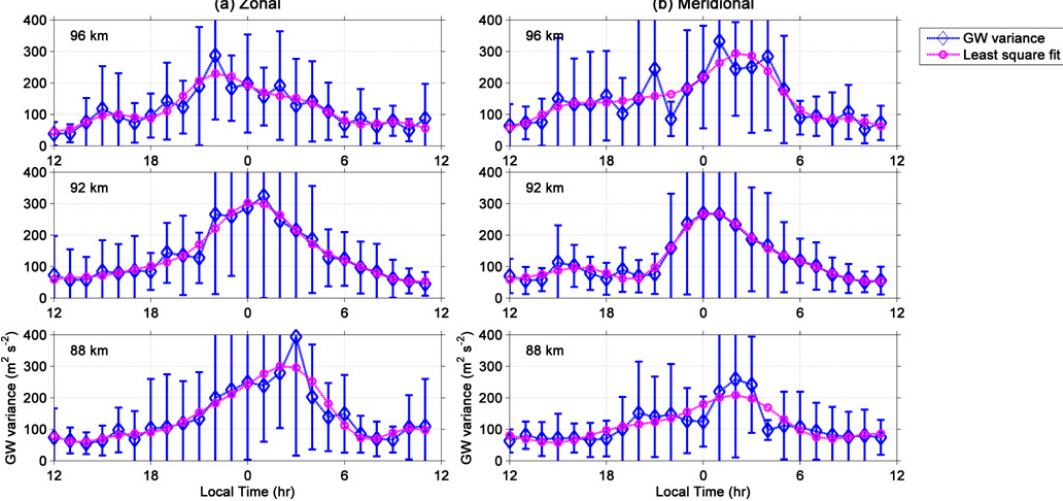
Fig. 1. Diurnal variation of 20–120min GW variance averaged from 1–31 March 2008 for (a) zonal, and (b) meridional components at heights of 96km, 92km, and 88km (from top to bottom). The over plotted magenta line in each panel represents least square fit by considering the diurnal, semi-, ter- and quarter-diurnal